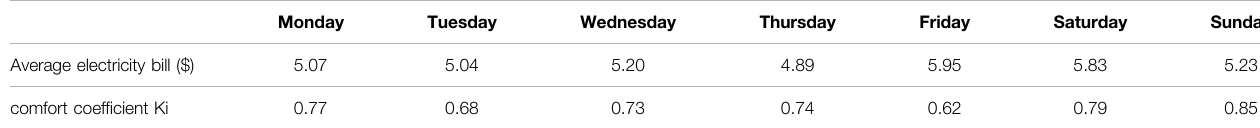
TABLE 1 | A week ’ s average electricity bill and comfort index table.